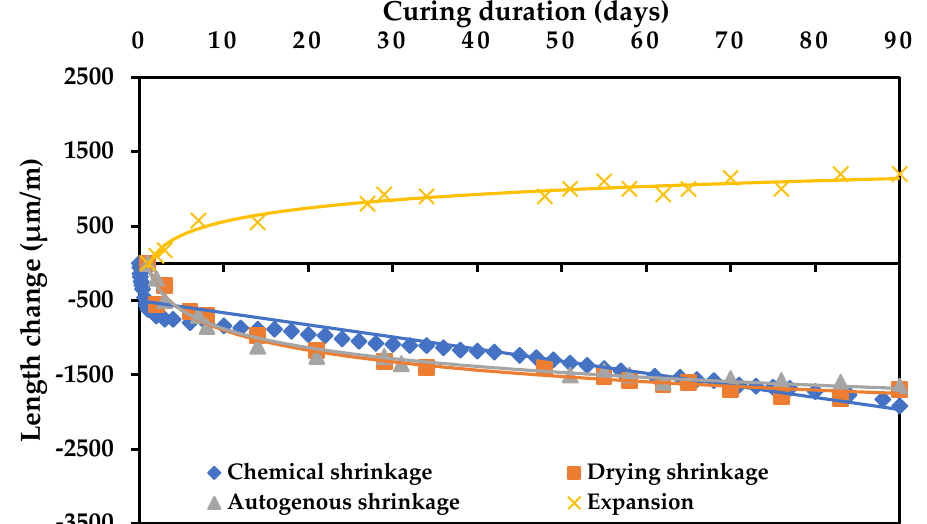
Figure 12. Length change of pastes with 10% LF.